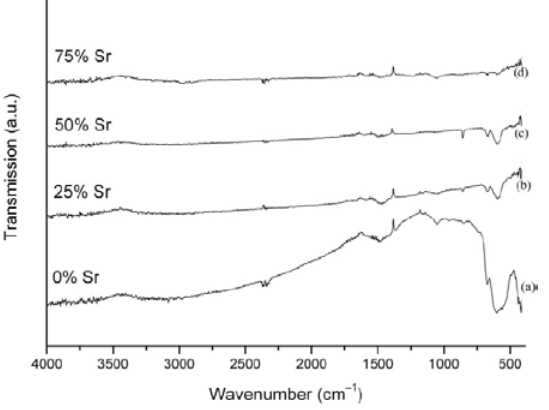
Figure 3. Infrared spectra of (a) La-Co-O, (b) La(0.75)-Sr(0.25)- Co-O, (c) La(0.5)-Sr(0.5)-Co-O, and (d) La(0.25)- Sr(0.75)-Co-O precursor gels.